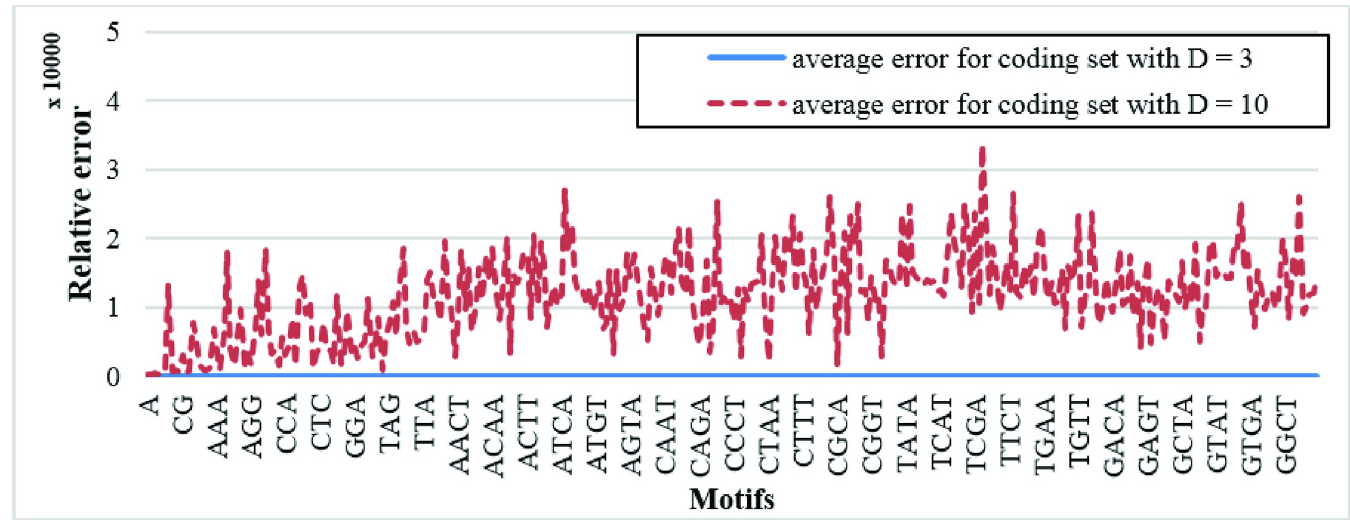
Fig 15. Average relative errors of cross-correlating all motifs with length 1 to 4 and first 1260 bp of first 12 chromosomes of Homo sapiens GRCh38.p12 data (sequences are encoded by coding set with d = 10, N = 30, E = 12, and zero-score, each line of SLM cosist of 42 columns and extra 2 pixels are added around each coding). Result of optical simulation is compared with ideal